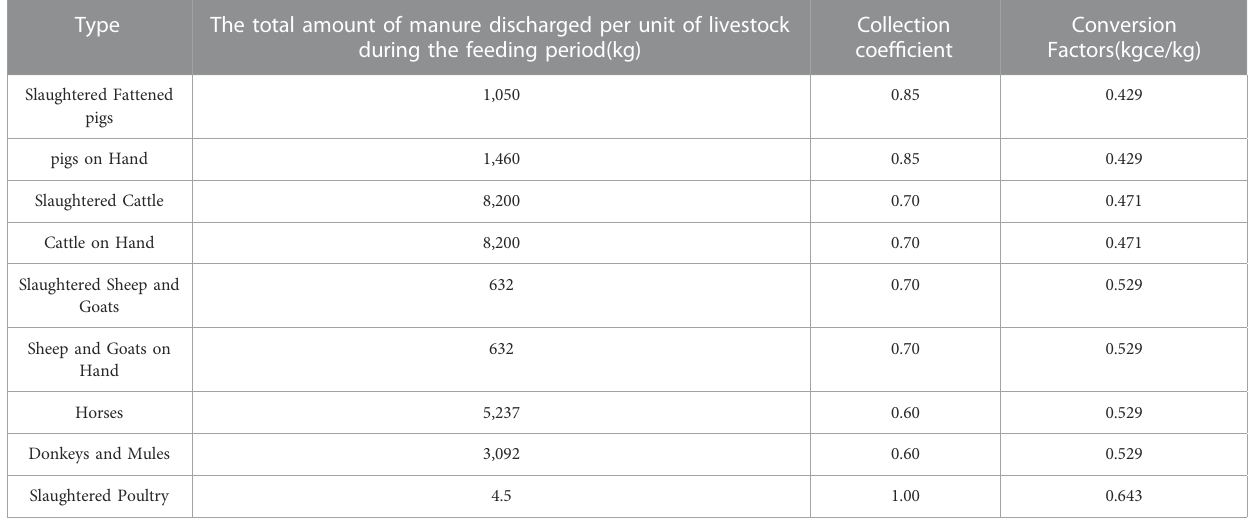
TABLE 4 The total amount of manure discharged during the feeding period of livestock, collection coef fi cient, and conversion factors.